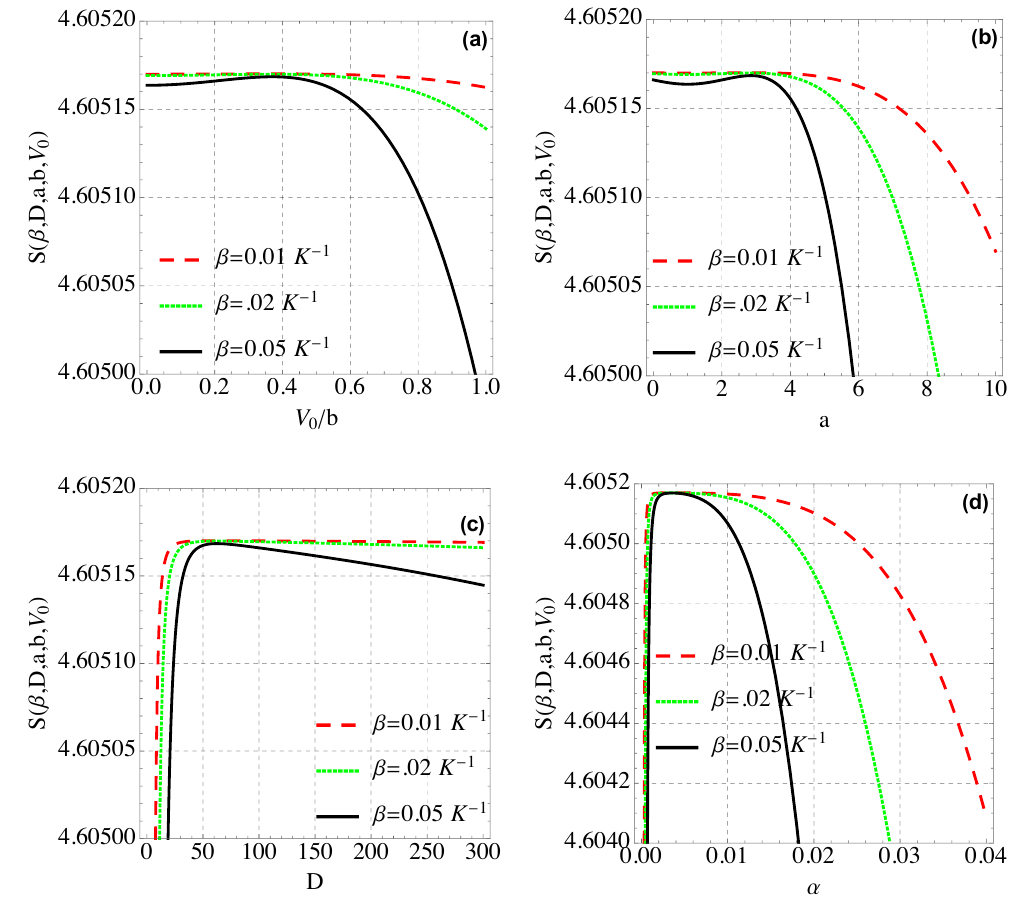
Figure 6. ( a ) Entropy S ( β , D , a , b , V 0 ) versus V 0 / b , ( b ) parameter a , ( c ) D and ( d ) screening parameter α for β = 0.01K − 1 (red curve), 0.02K − 1 (green curve), 0.05K − 1 (black